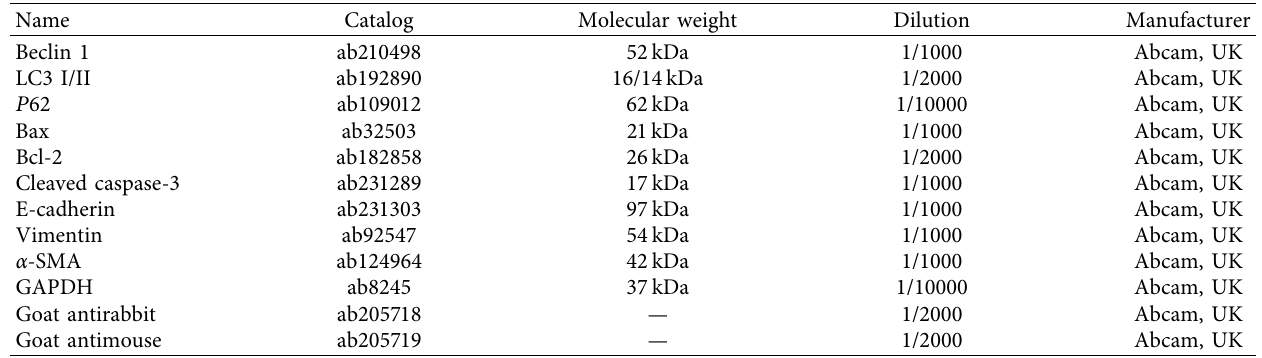
Table 1: Antibodies used in this